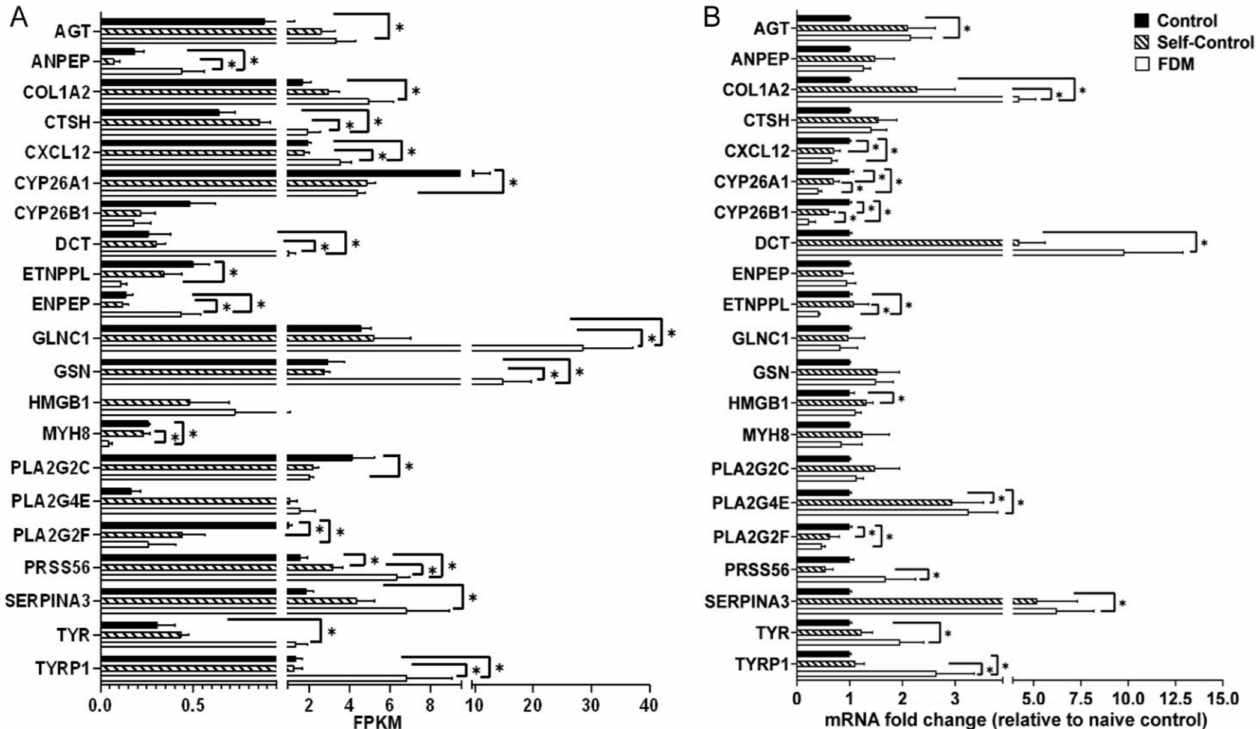
Figure 10. Verification of gene expression in naïve control, self-control and FDM eyes. ( A ) Histogram showing the FPKM (fragment per kilobase of transcript per million fragments) of representative DEGs among the three groups in RNA sequencing. ( B ) The relative gene expression measured by qPCR. Data presented as fold change of gene expression compared to native control. Mean ± SD, n = 4/group in ( A ), n = 6~8/group in ( B ). * p < 0.05. One-way ANOVA followed by Fisher’s LSD